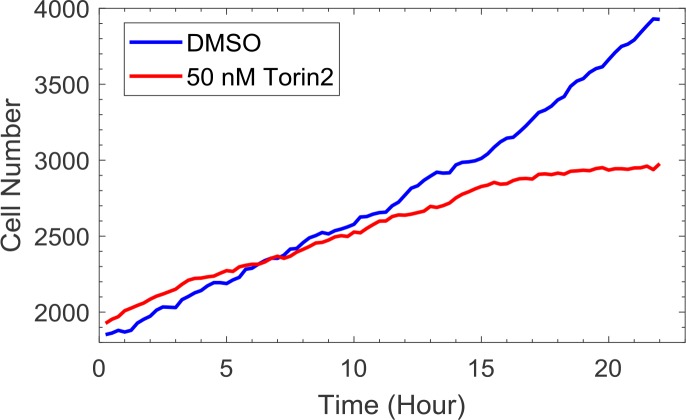
Cells are still cycling upon Torin-2 treatment.Measurements were obtained by time-lapse microscopy with cells expressing fluorescent markers of H2B. Cells were imaged and counted every 15 min over 22 hr. Compound treatment were performed at time 0.